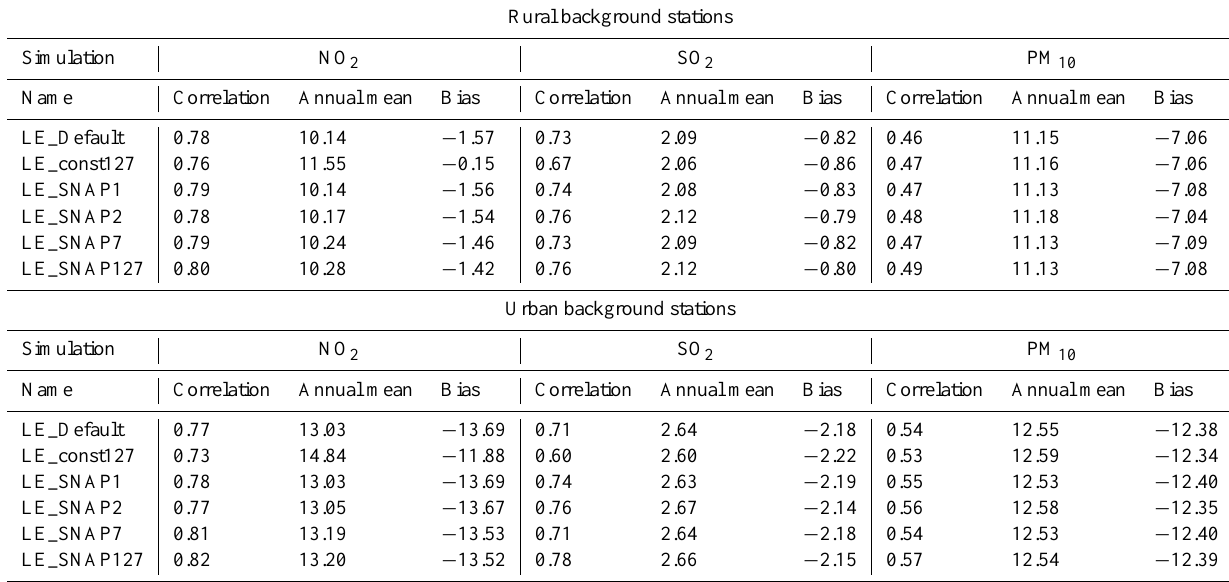
Table 4. Statistical overview of model performance averaged over all available stations based on daily data. Twenty-four rural background stations and 48 urban background stations are included in the statistics. Annual mean and bias are given in µgm − 3